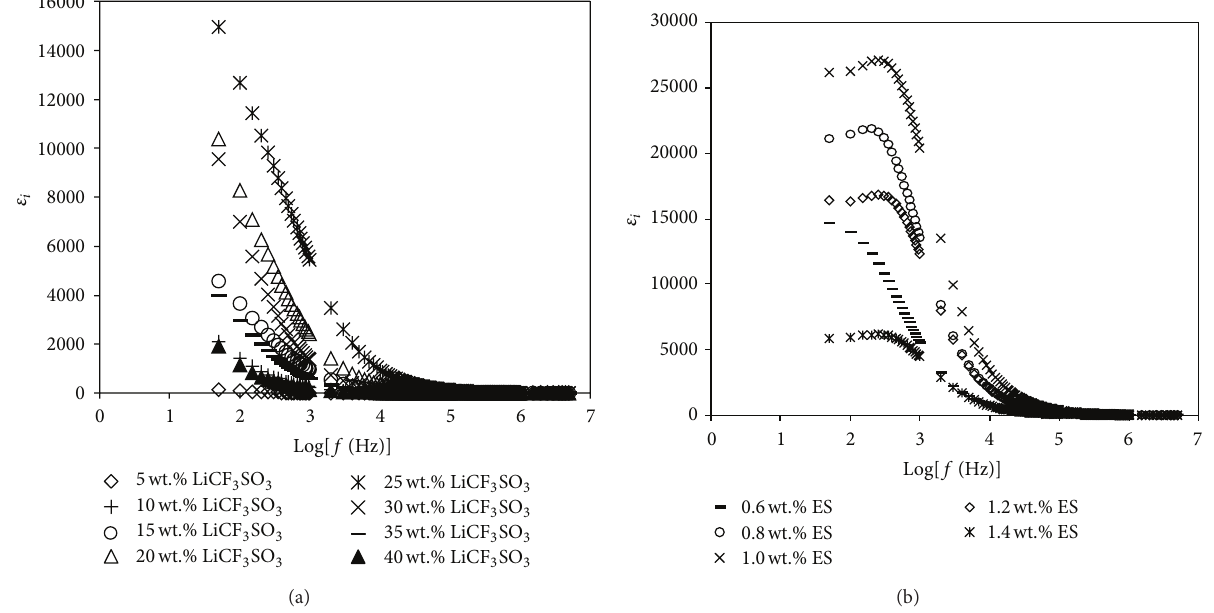
Figure 8: The frequency dependence of dielectric loss, 𝜀 𝑖 , at room temperature: (a) salted system and (b) plasticized system for selected